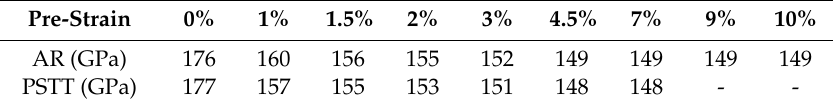
Table 3. Chord modulus evolution of the Inco718 material.